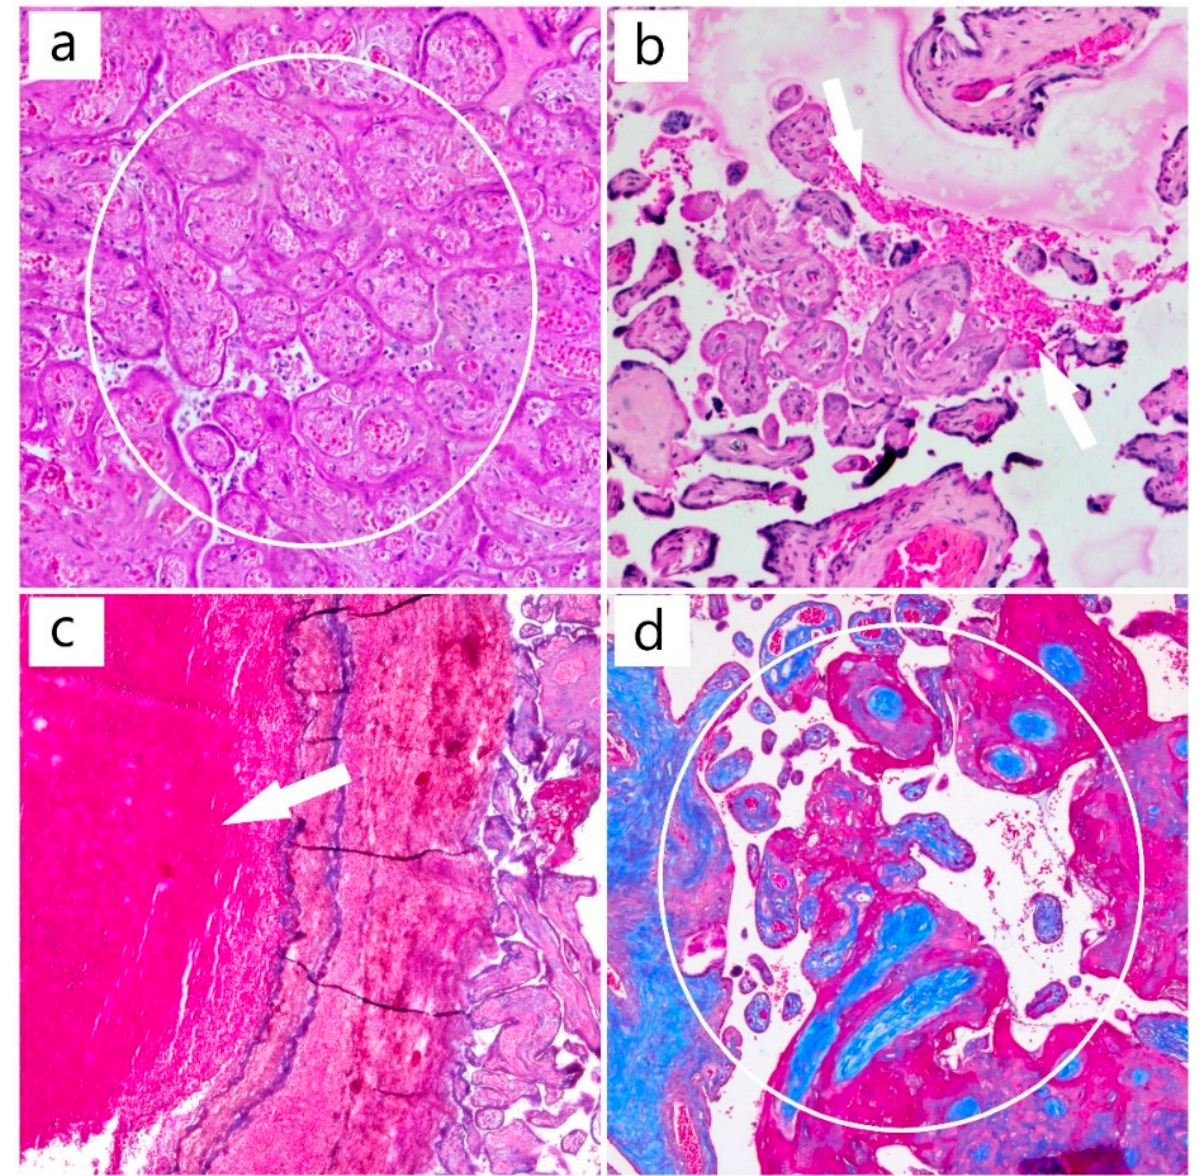
Figure 3. ( a ) Area of placental infarction (HE, ob. 10×) (circle); ( b ) areas of intervillous hemorrhage (HE, ob. 10×) (arrow); ( c ) mixed thrombus (HE, ob. 10×) (arrow); ( d ) chorionic villi (Masson’s (HE, ob. 10 × ) (arrow); ( c ) mixed thrombus (HE, ob. 10 × ) (arrow); ( d ) chorionic villi (Masson’s trichrome special stain, ob. 10×) (circle). trichrome special stain, ob. 10 × )